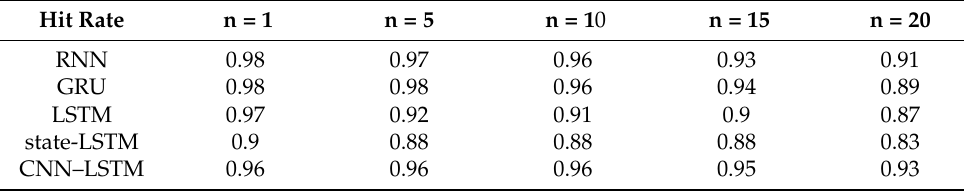
Table 2. Hit rate of trajectory prediction (n is the time